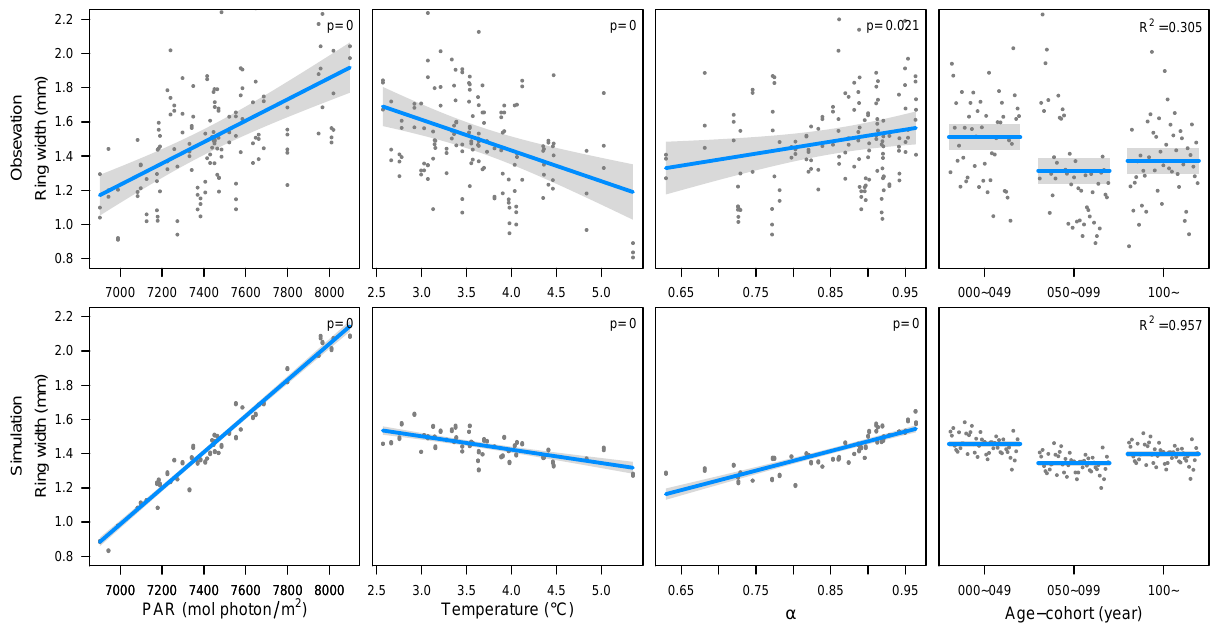
Figure 5. Tree-growth response to climate and tree age: partial residual plots based on the GLM analysis (Table 2), obtained using the visreg package in R , are shown.